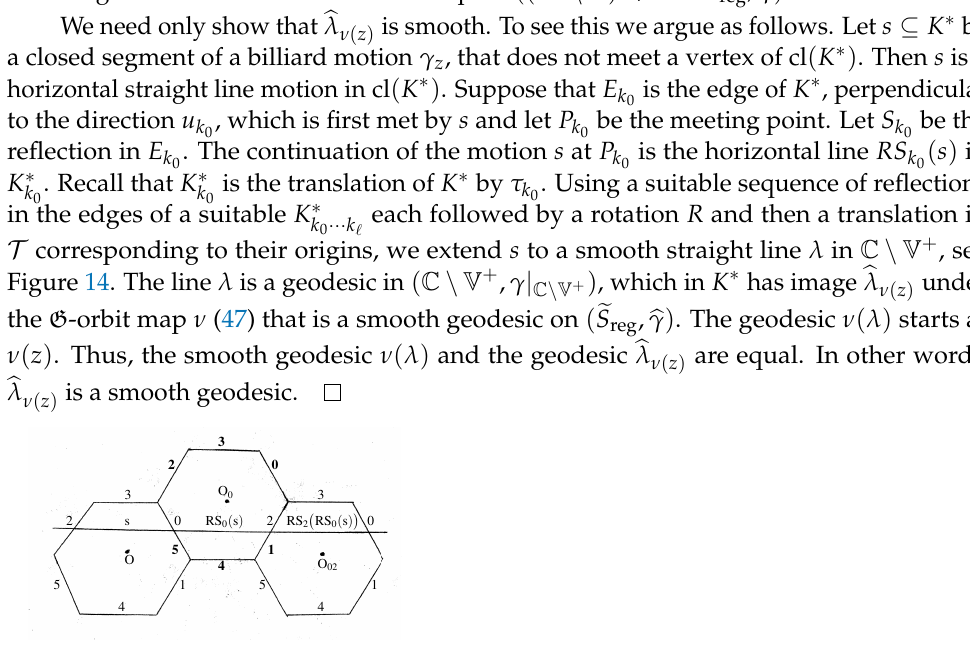
Figure 14. The billiard motion γ z in the stellated regular 3-gon K ∗ this edge by S 0 , and then is rotated by R . This gives an extended motion RS 0 γ z , which is a straight line that is the same as reflecting γ z by U and then translating by τ 0